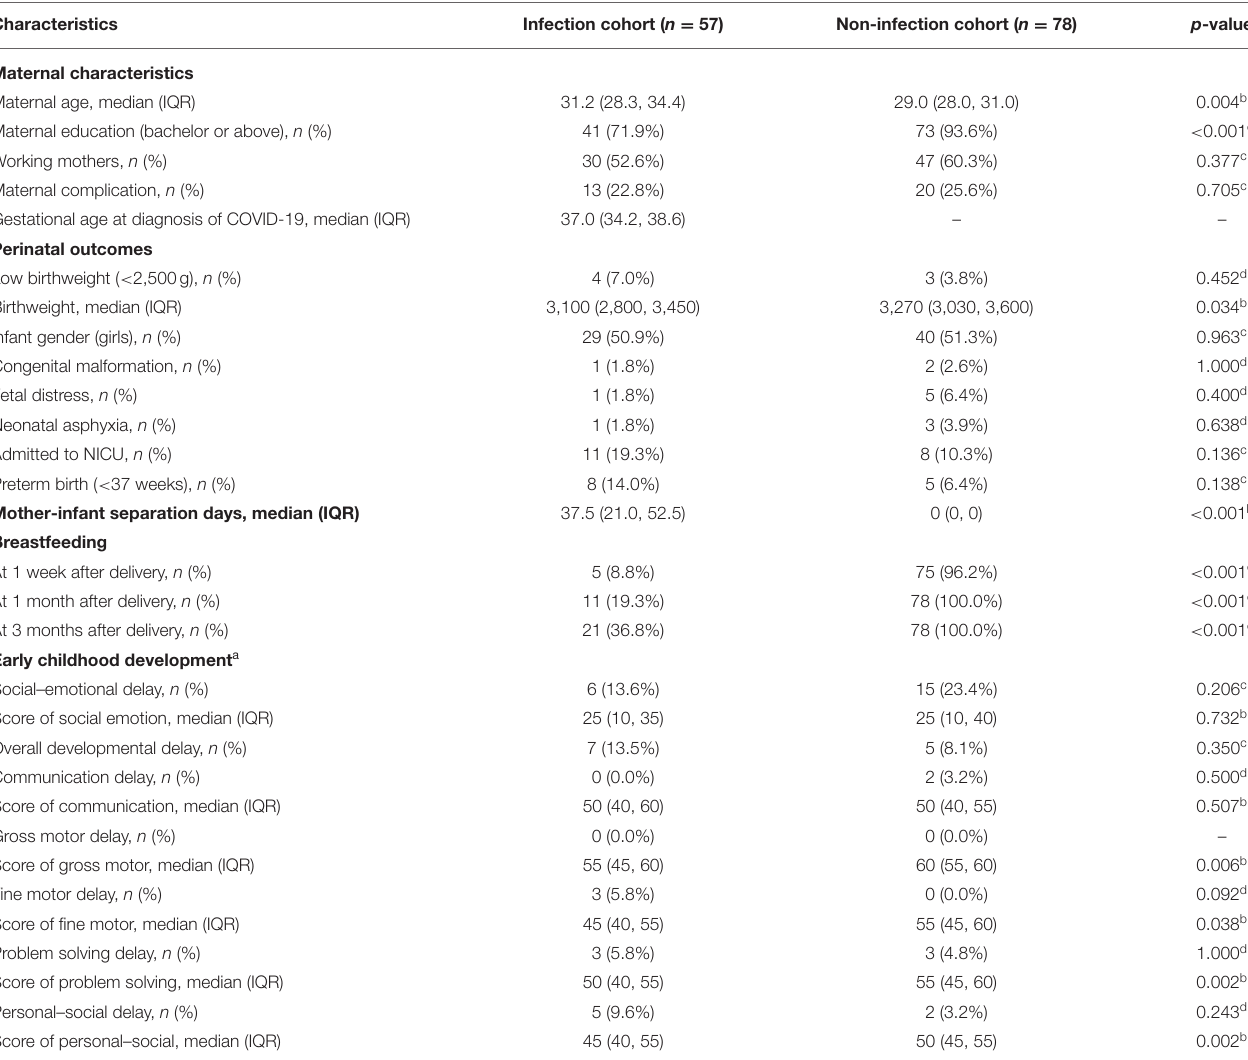
TABLE 1 | Demographic characteristics, perinatal outcomes, and early childhood development between infection cohort and non-infection cohort.